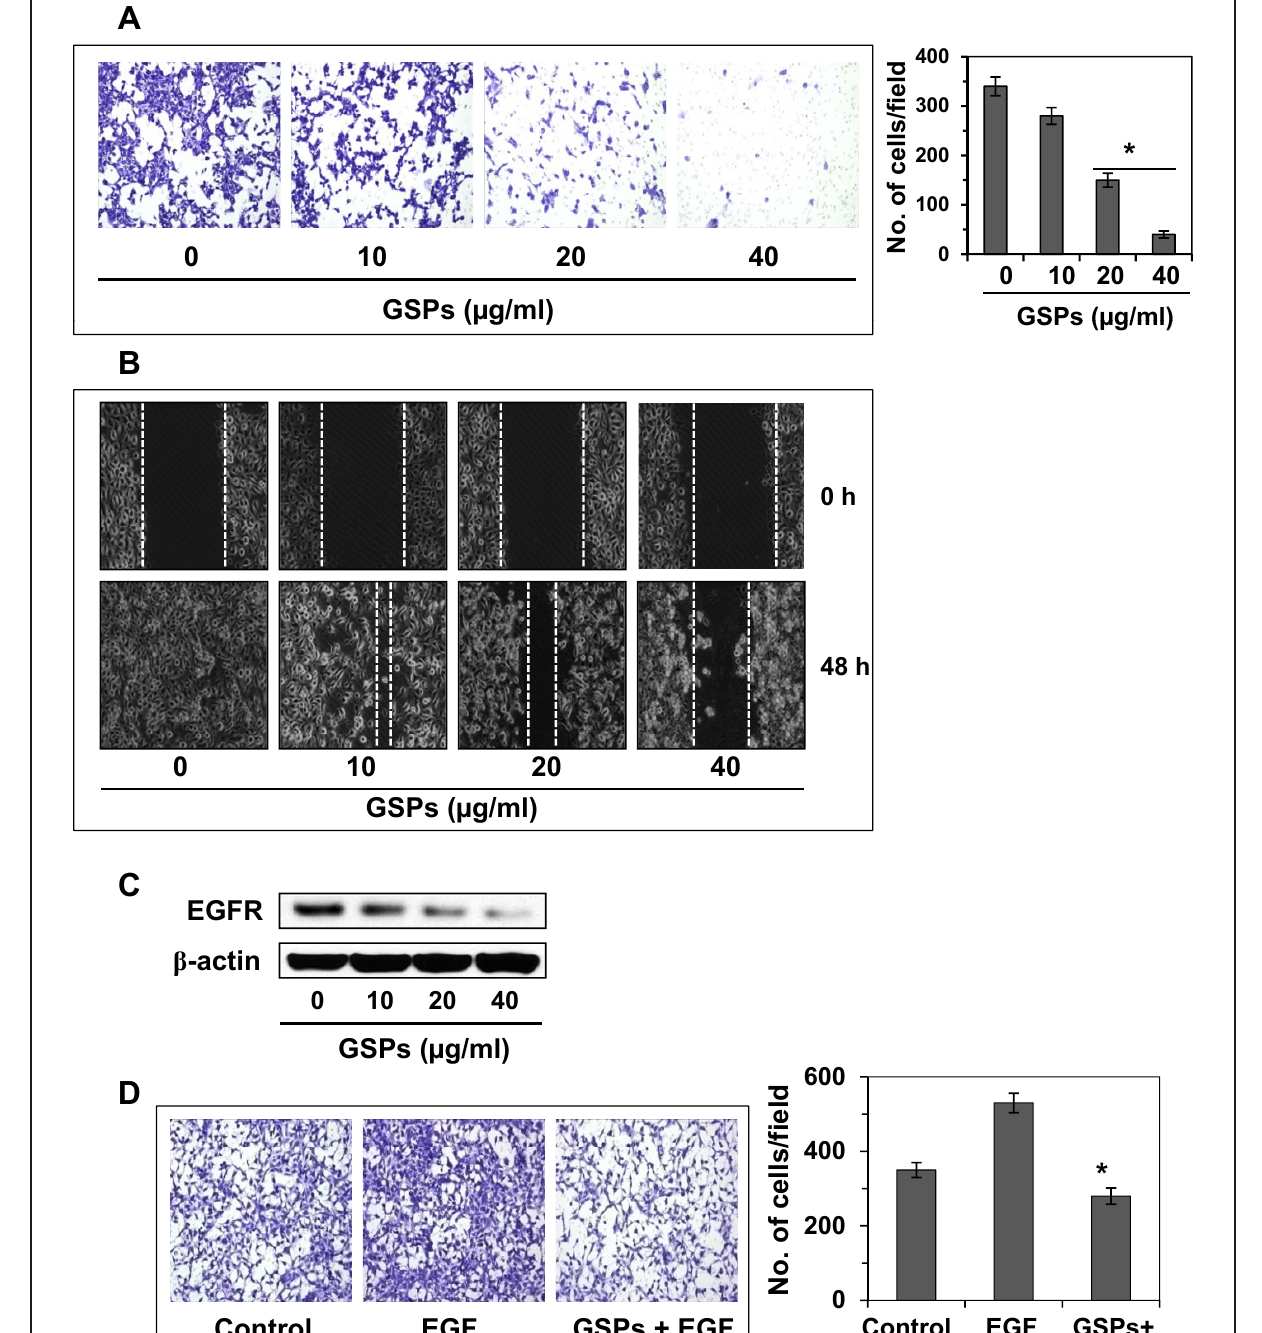
Figure 2 Effect of GSPs on cutaneous HNSCC cell invasion . (A) Treatment of cutaneous HNSCC cells (SCC13) with GSPs for 12 h inhibit invasion of cells in a concentration-dependent manner compared to non-GSPs-treated control cells. The invasive cells were counted and the results expressed as the mean number of invasive cells ± SD/microscopic field (right panel). Significant inhibition versus non-GSPs-treated control, * P < 0.001. (B) Wound healing assay was performed to assess the effect of GSPs on the migration of SCC13 cells. Incubation of SCC13 cells with GSPs for 48 h inhibits migration of cells in a concentration-dependent manner compared to non-GSPs-treated control cells. Broken white line indicates the gap without the presence of cells. Representative pictures are shown from three separate experiments under identical conditions. (C) Dose- dependent effect of GSPs on the EGFR expression of SCC13 cells. The levels of EGFR were determined in cell lysates using western blot analysis. (D) GSPs inhibit EGF-induced invasion of SCC13 cells. Treatment of SCC13 cells with EGF results in enhancement of cell invasion, and treatment of GSPs inhibit EGF-induced invasion of SCC13 cells. The data on cell invasion in each treatment group is summarized and the results expressed as the mean number of invasive cells ± SD/microscopic field (right panel). Significant inhibition versus EGF alone-treated group, * P <